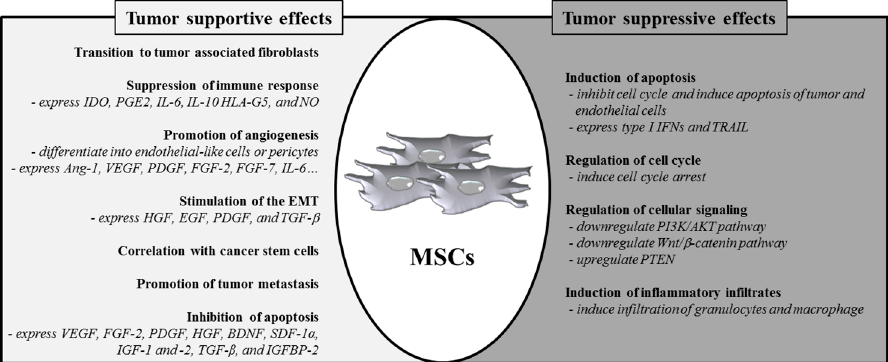
Figure 1. Role of MSCs in tumor formation or suppression. MSCs can regulate transition to tumor-associated fibroblasts, immune response, angiogenesis, EMT, cancer stem cells, metastasis, and apoptosis. Alternatively, growing evidence shows that MSCs inhibit tumor cell function by inducing apoptosis, cell cycle arrest, and inflammatory infiltration and inhibiting the Wnt and AKT signaling pathways.